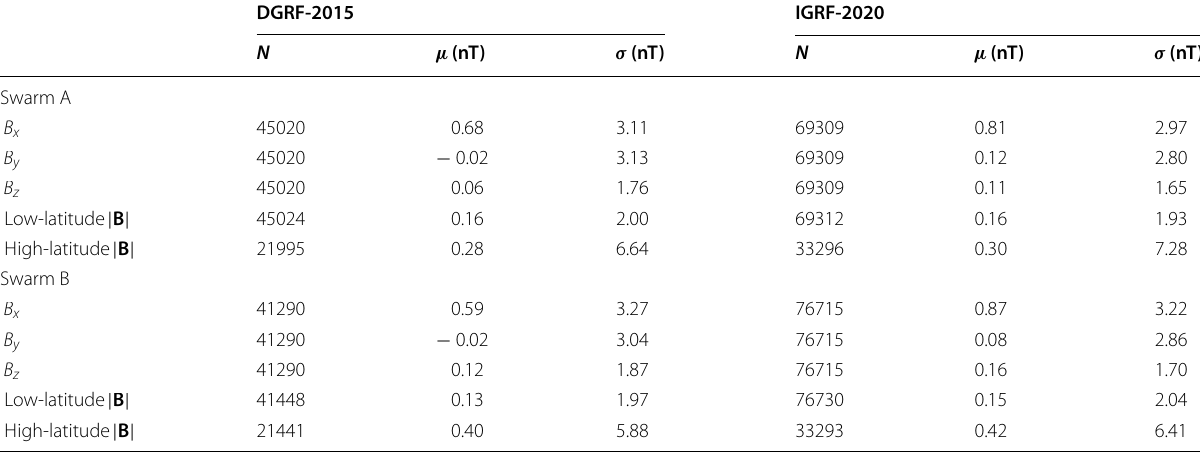
Table 1 Residual statistics of IGRF-13 parent models. Columns show the number of data points ( N ), residual mean ( µ ) and residual standard deviation ( σ ). Low-latitude residuals are computed from data equatorward of ± 55 ◦ QD latitude. High-latitude residuals are computed from data poleward of ± 55 ◦ QD